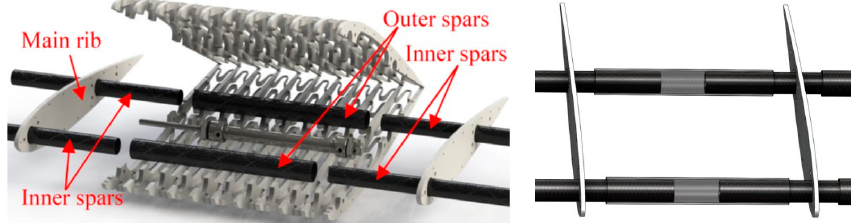
Figure 5. ( left ) Exploded view of a wing partition, ( right ) interconnected telescoping spars.